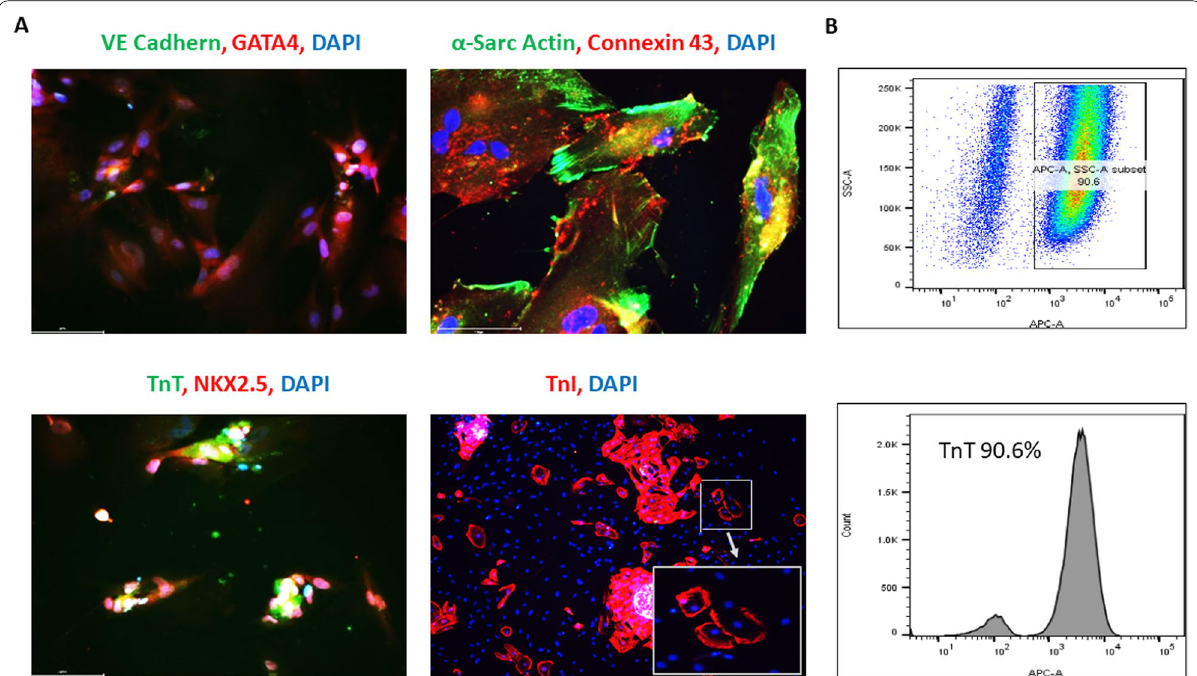
Fig. 8 Effect of GIV on differentiation of hiPSCs to cardiac myogenic cells. A Cells were immunostained positive for different cardiac progenitors’ markers as Nkx2.5, GATA4, TnT, VE cadherin, α-sarcomeric actin and connexin 43 (40X), but TnI (10X) at 30 days. B Flow cytometry analysis of hiPSC-cardiac progenitor stained for Alexa Fluor ® 647-conjugated cardiac troponin T. The analysis showed that 90.6% of the population of hiPSC- cardiac progenitor was cardiac troponin